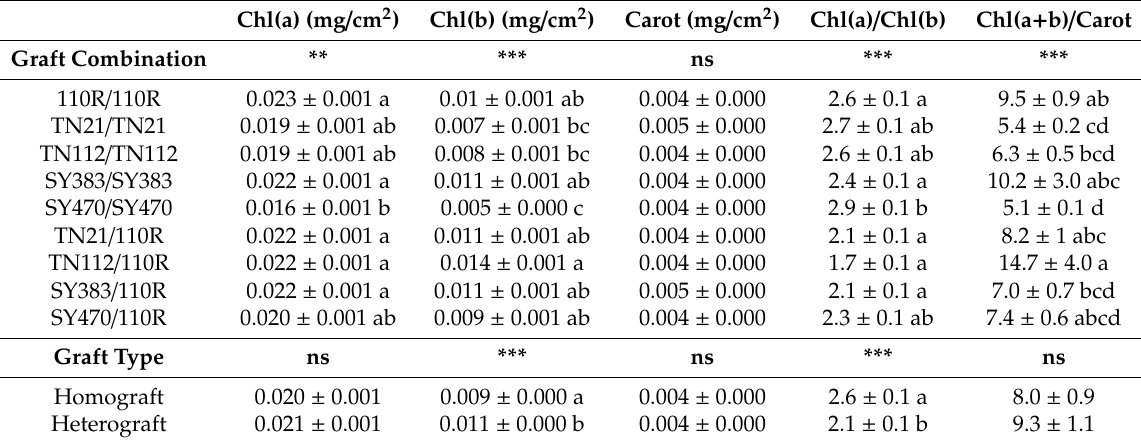
Table 3. Mean values of chlorophyll and carotenoid content per graft combination and graft